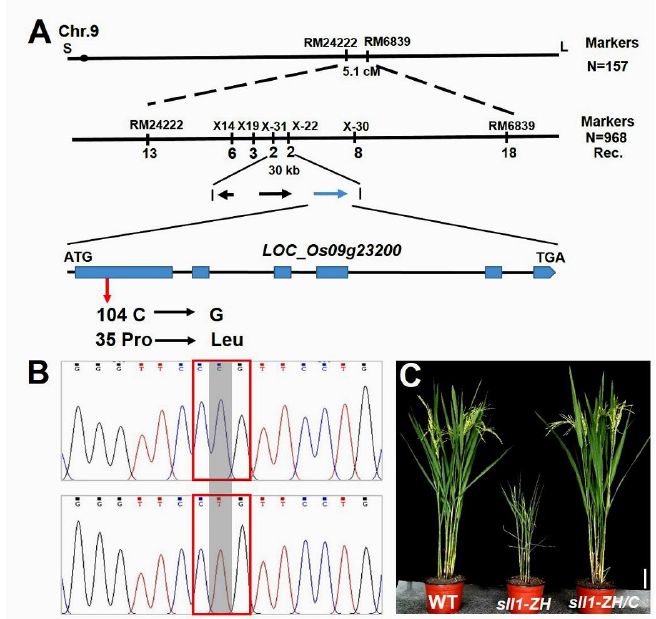
Figure 3. Map-based cloning of the SLL1-ZH gene. ( A ) Fine mapping and candidate gene analysis of the SLL1-ZH locus. ( B ) Sequencing validation of the point mutation between the WT (top) and the sll1-ZH mutant (bottom) alleles. The red arrow indicates the position of the c nucleotide muta- tion in sll1-ZH. ( C ) Characterization of the complemented transgenic plant compared to WT and the mutant. Scale bar = 20 cm.